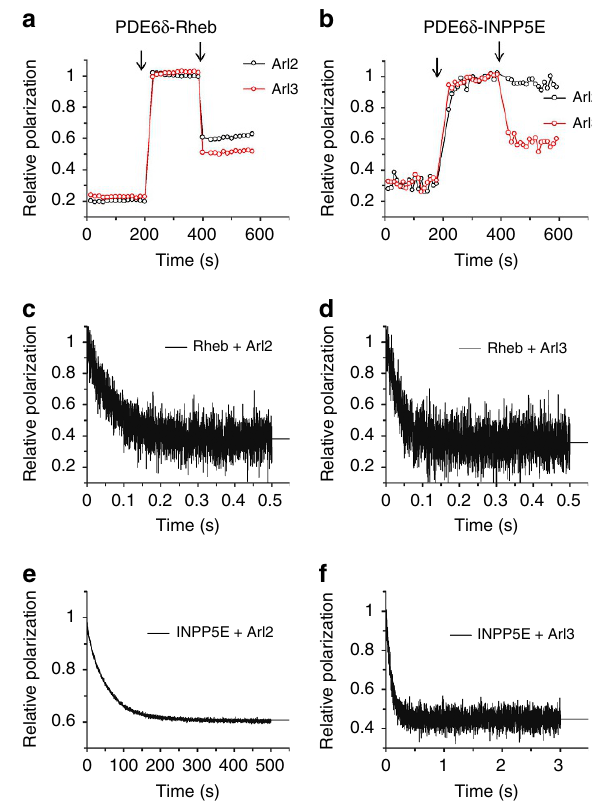
Figure 2 | INPP5E release from PDE6 d by Arl2 (cid:3) GppNHp and Arl3 (cid:3) GppNHp. ( a ) Fluorescence polarization measurements of 0.5 m M FITC-labelled Rheb peptide followed by addition of 0.5 m M PDE6 d and the addition of 5 m M Arl2 (cid:3) GppNHp or Arl3 (cid:3) GppNHp (arrow). ( b ) Fluorescence polarization measurements of 0.2 m M TAMRA-labelled INPP5E peptide followed by the addition of 0.2 m M PDE6 d (arrow) and 5 m M Arl2 (cid:3) GppNHp or Arl3 (cid:3) GppNHp (arrow). ( c – f ) Stopped-flow fluorescence polarization kinetic experiment where complexes of 1 m M PDE6 d with either 0.2 m M of FITC-labelled Rheb peptide ( c , d ) or TAMRA-labelled farnesylated INPP5E peptide ( e , f ) were mixed with 100-fold excess of unlabelled peptide and 10 m M of Arl2 ( c , e ) or Arl3 ( d , f ) as indicated. important to release myristoylated cargo from a complex with the shuttle factor UNC119 (ref. 30). To find out whether the N-terminus of Arl3 and/or Arl2 has a similar if any role in the interaction with PDE6 d , fluorescence polarization measurements using full-length Arl3 (Arl3 fl ) or an N-terminal truncated form (Arl3 D N ) were performed. Supplementary Fig. 1 shows that Arl3 D N is unable to release the INPP5E peptide from PDE6 d as compared with Arl3 fl . To investigate the role of the N-terminal helix of Arl3 in the release mechanism, we measured association and dissociation rate constants to determine the affinity of PDE6 d towards Arl2 and Arl3 in both full-length and N-terminal trun- cated forms. Association rate constants between the four proteins Arl3 fl , Arl3 D N , Arl2 fl and Arl2 D N are rather similar although association is almost twice as fast for full-length Arl3 as compared with Arl2 (Fig. 3a,b). In contrast, determination of the dissocia- tion rate constants shows large differences. While the difference in k off between full-length protein Arl2 fl and N-terminal deleted Arl2 D N is only threefold, Arl3 fl shows a 26-fold higher residence time with PDE6 d , as compared with Arl3 D N (Fig. 3c–e). By calculating the equilibrium dissociation constants ( K d ¼ k off / k on ), Arl3 D N , Arl2 fl and Arl2 D N exhibit affi- nities in the submicromolar range (217 ± 4.3, 149 ± 19 and